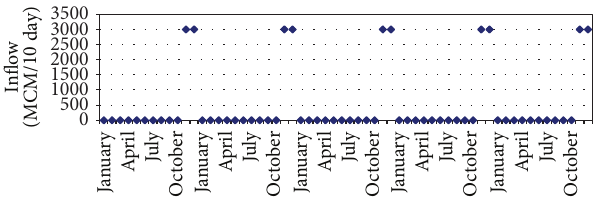
Figure 6: Virtual inflow time series.